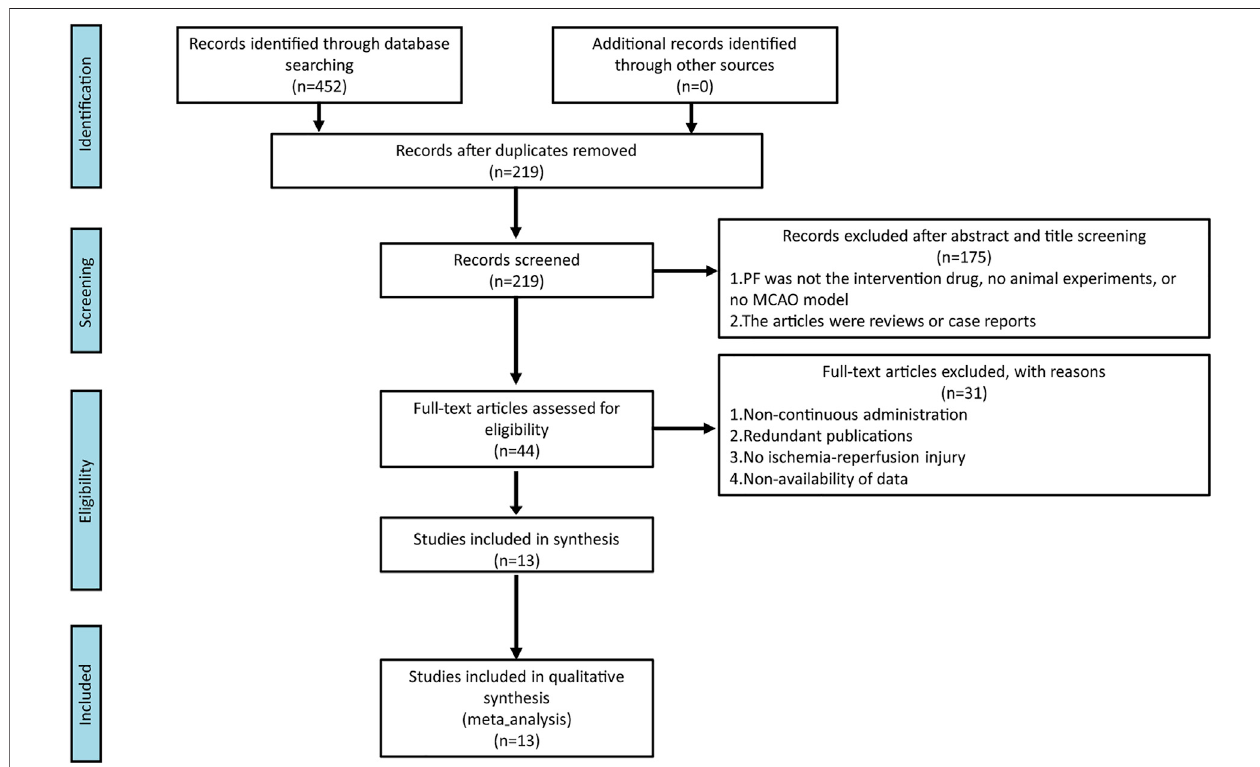
FIGURE 2 | Flow diagram of the study-search